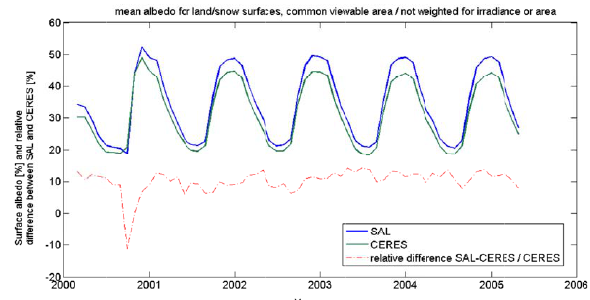
Fig. 8. Comparison of monthly mean surface albedos from CLARAA1 SAL (blue line) and CERES FSW (green line) between 2000–2005 (unit is percent). The means of each month are calcu- lated only over those land/snow surfaces that are retrieved in both products. No weighing for irradiance has been applied. The relative difference between the products is shown with a red dash-dotted